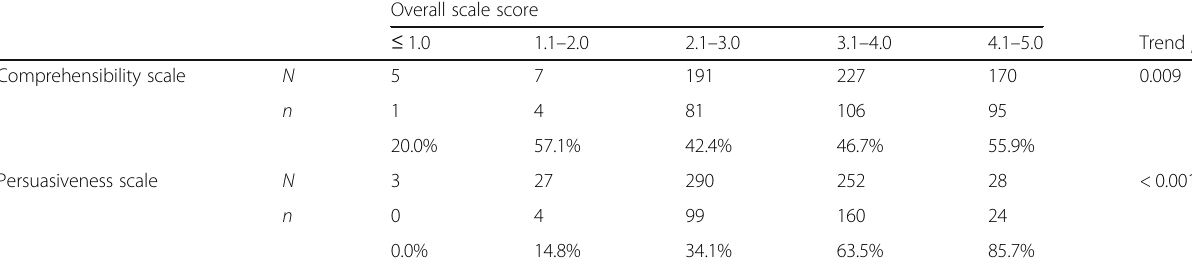
Table 5 Association between the overall scale score and help-seeking intention for insomnia Overall scale